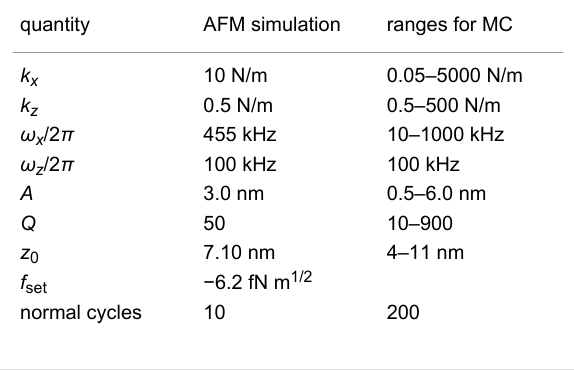
Table 1: Parameter set for simulations with KBr potential, and ranges for MC parameter sampling.